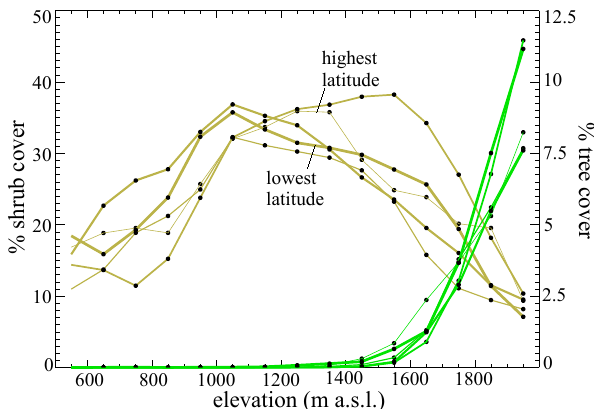
Figure 8. Plot of the average percent shrub (in brown) and tree (in green) cover in the Mojave Desert as a function of elevation for 5 bins of latitude (thinner lines indicate higher latitudes) using the US Geological Survey’s (2013) LANDFIRE database. The data exhibit some spatial variation in the vegetation-cover-versus-elevation rela- tionship, but there is no systematic difference across